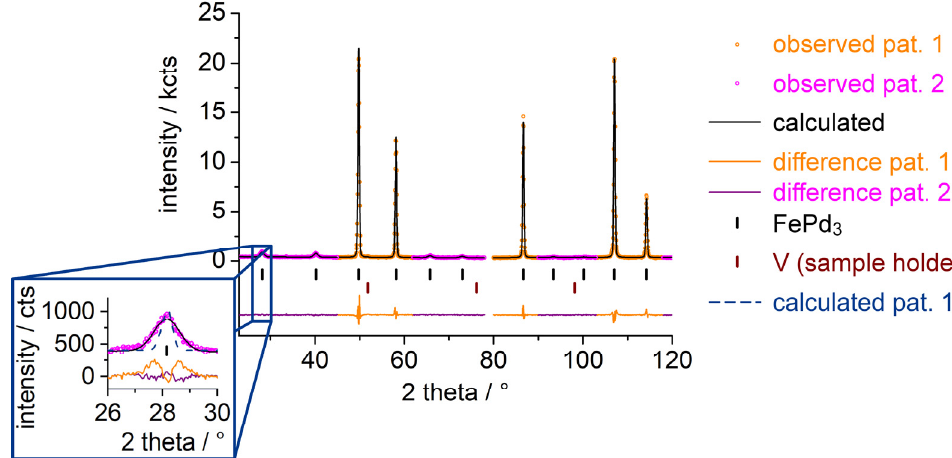
Figure 2. Simultaneous Rietveld refinement ( Χ ² = 1.97) of the crystal and magnetic structure of FePd 3 (AuCu 3 type, Pm 3 (cid:3364) m , a = 385.204(6) pm, R Bragg (pat.1) = 2.13, R Bragg (pat.2) = 6.73, R magn (pat.1) = 2.26, R magn (pat.2) = 6.12; for further details, see Tables 1 and A5 and the text) at 296(1) K based on neutron powder diffraction data (NUMOR 131401 [21], λ =186.80(2) pm, D20 ILL, Grenoble, R p (pat.1) = 0.057, R p (pat.2) = 0.069, R wp (pat.1) = 0.080, R wp (pat.2) = 0.087, background corrected: R ’ p (pat.1) = 0.083, R ’ p (pat.2) = 0.667, R ’ wp (pat.1) = 0.100, R ’ wp (pat.2) = 0.410) and XRPD data (Figure A1, Co-K α radiation, Smart Lab, R p (pat.3) = 0.105, R p (pat.4) = 0.102, R wp (pat.3) = 0.150, R wp (pat.4) = 0.140, R ’ p (pat.3) = 0.160, R ’ p (pat.4) = 1.90, R ’ wp (pat.3) = 0.192, R ’ wp (pat.4) = 0.804) using FullProf [24]. The inset shows the broadening of pattern 2 reflections through a comparison of intensities for 100 reflections calculated with the reflection width of pattern 1 (blue dashed line) and the reflection width of pattern 2 (black line) with the respective difference plot. Table 1. Crystal structure parameters of FePd 3 ( Pm 3 m ) based on neutron powder diffraction ( a = 385.204(6) pm, µ Fe = 2.3(2) µ B ; see Figure 2) and XRPD ( a = 385.390(3) pm; compare Figure A1) at 296(1) K.